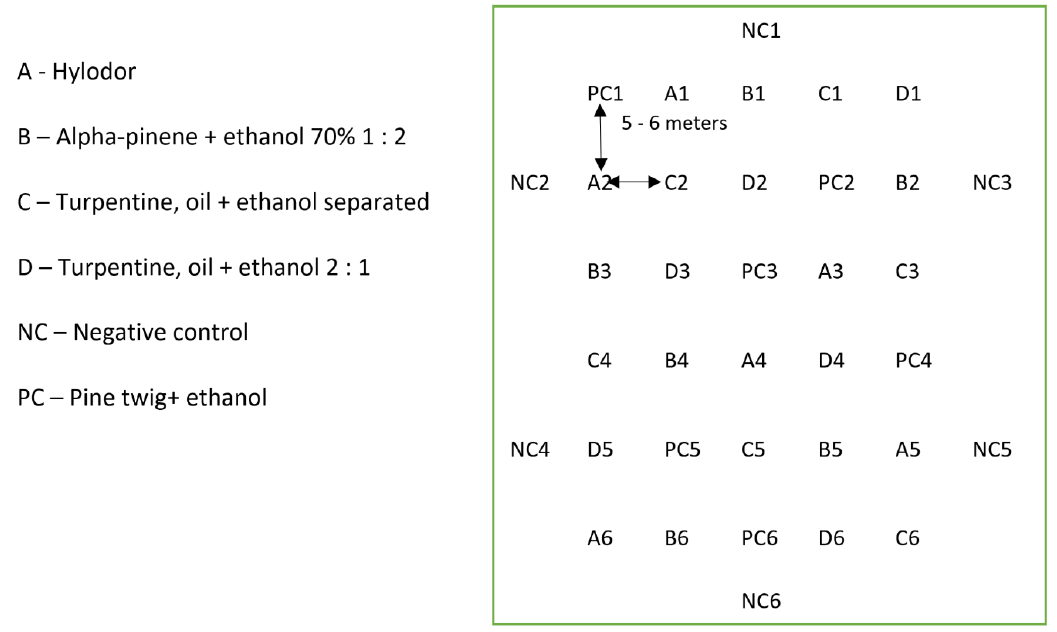
Figure 2. Photographs of representative pitfall traps and different type lure (a-d)